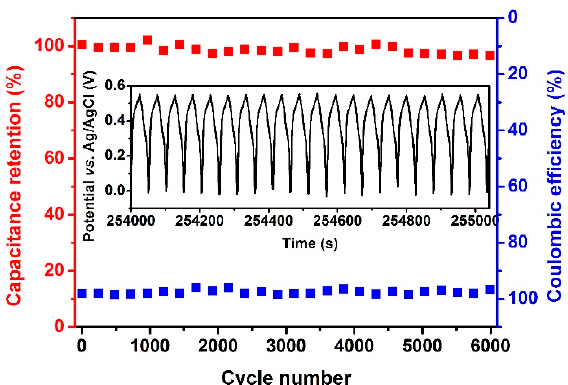
Figure 7. Cycling performance and coulombic efficiency of the Co 3 O 4 electrode. Table 1. Brief capacitance, rate, and cycling performance list of Co 3 O 4 -based electrode materials. Specific Material Rate Capability Stability-Cycles Capacitance